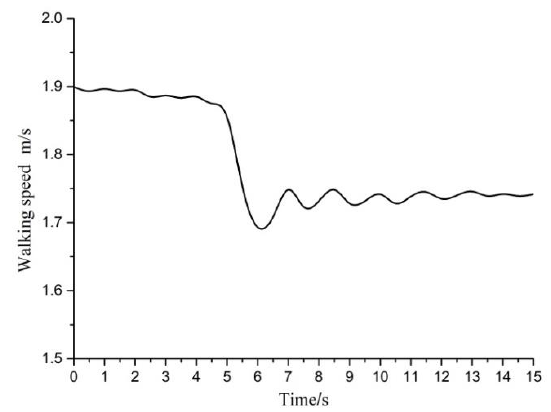
Figure 12. The relationship curve of walking speed and time.